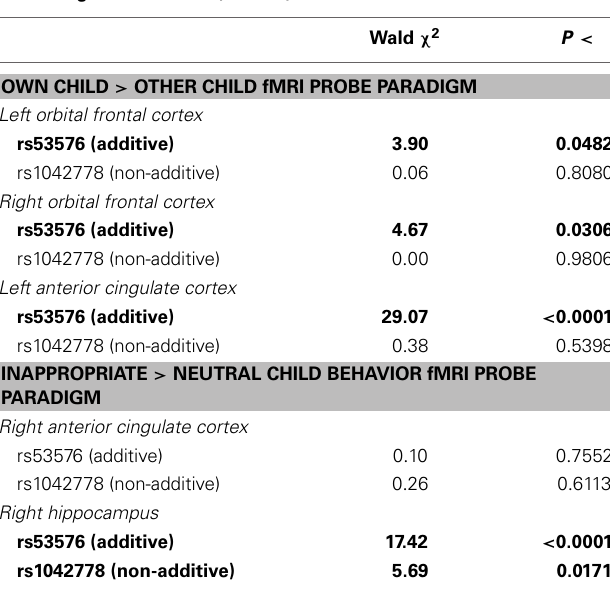
Table 3 | Results of simultaneous regression analyses testing associations of each additive and non-additive genetic term (each DF = 1) for OXTR rs53576 and rs1042778 with each neural region of interest that was both significantly activated in the fMRI paradigm and found to be significantly associated with observed positive maternal parenting with covariates, conducted separately for each neural region of interest ( N =